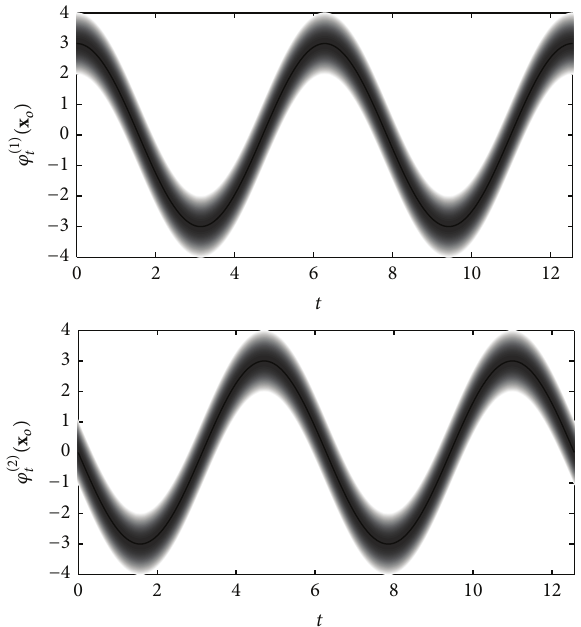
Figure 3: Time course of 𝜑 (1) 𝑡 ( x 𝑜 ) and 𝜑 (2) 𝑡 ( x 𝑜 ) , respectively.